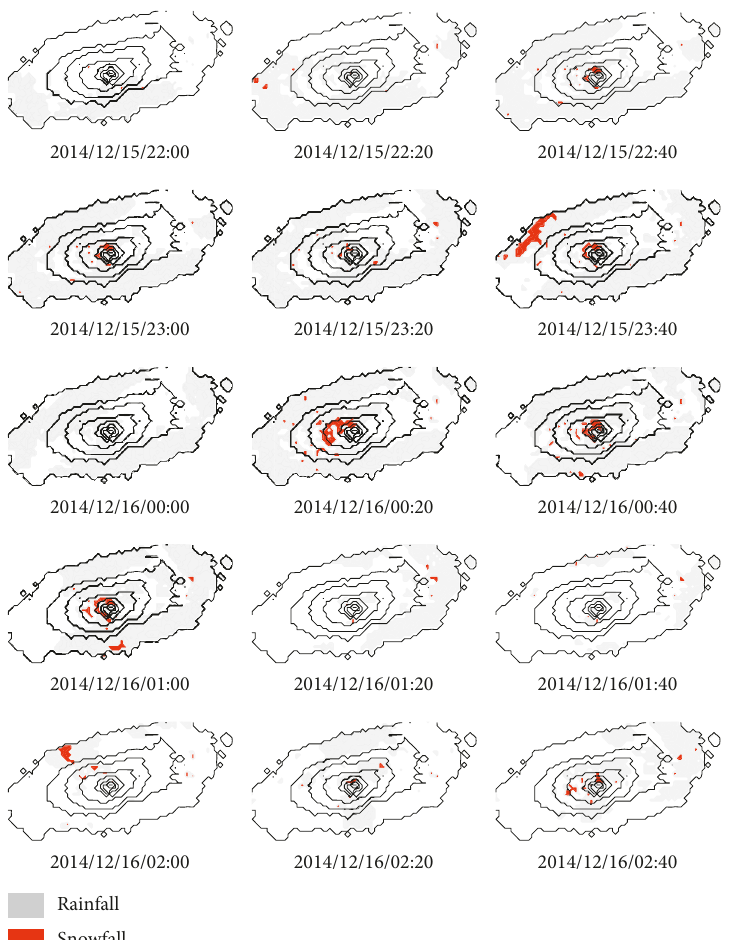
Figure 8: Mapping result of the snowy region by applying the fixed threshold method (from 22:00 December 15 to 02:40 December 16,